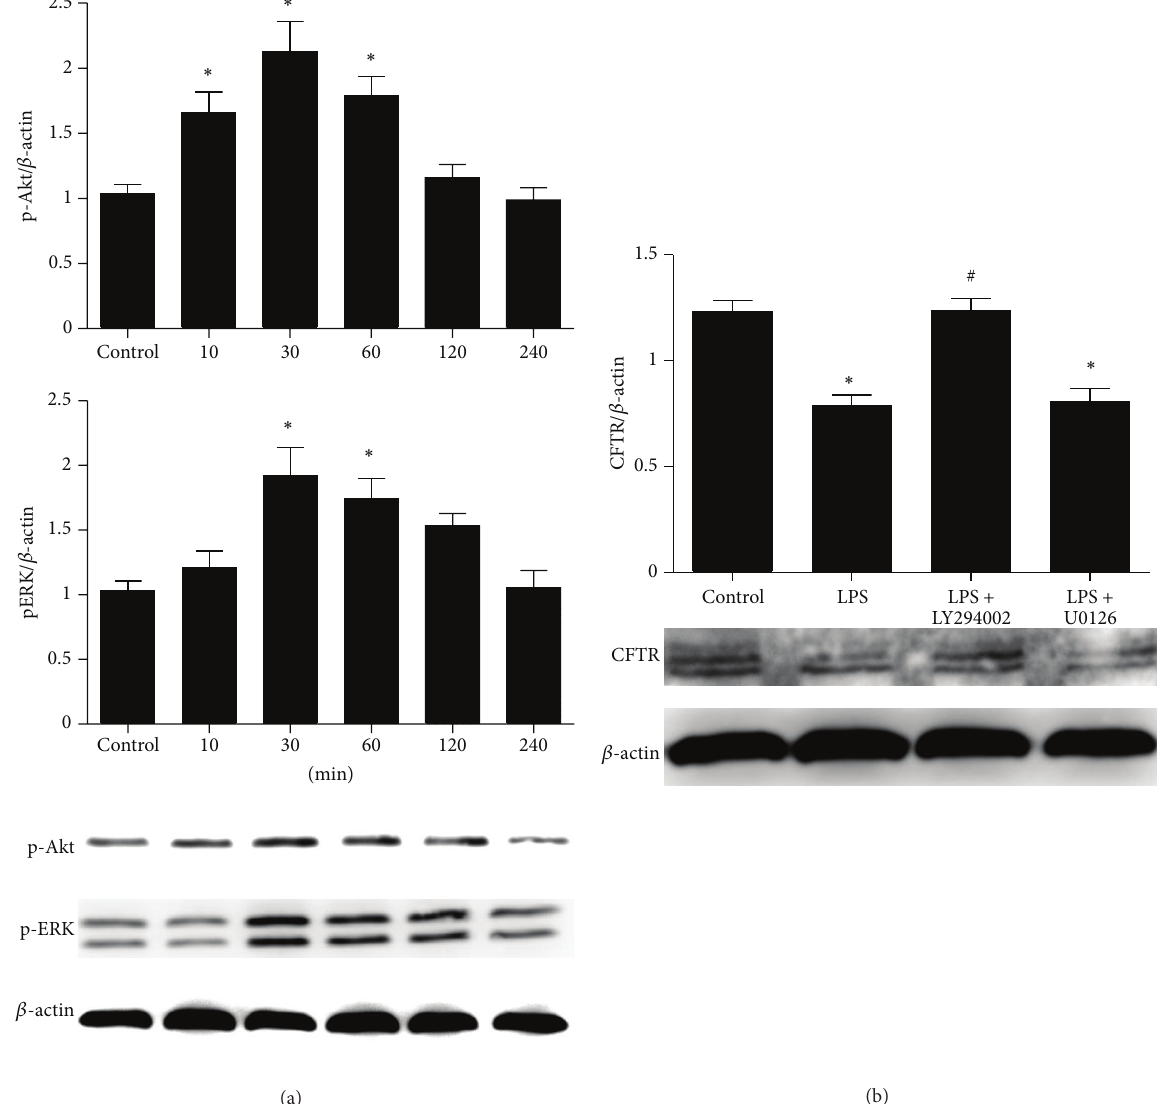
Figure5:LPSdecreasesproteinexpressionofCFTRviaPI3K/AktsignalingpathwayinATIIcells.ThecellswereincubatedwithLPS(1 𝜇 g/mL) for 10, 30, 60, 120, and 240min. After incubation, the cells were harvested and sonicated. (a) Phosphorylation of Akt and ERK in the cell lysates wereassessedbywesternblotting.(b)TheratprimaryATIIcellswerepretreatedwithLY294002(10 𝜇 M,PI3K/Aktinhibitor)orU0126(20 𝜇 M, ERK inhibitor) for 30min and then incubated with LPS (1 𝜇 g/mL) for 6h. After incubation, the cells were harvested, sonicated and CFTR protein detected by western blotting. Data were expressed as mean ± SEM for each group. ∗ 𝑃 < 0.05 versus control group, # 𝑃 < 0.05 versus LPS group, 𝑛 = 4 for each group. LPS = lipopolysaccharide, CFTR = cystic fibrosis transmembrane conductance